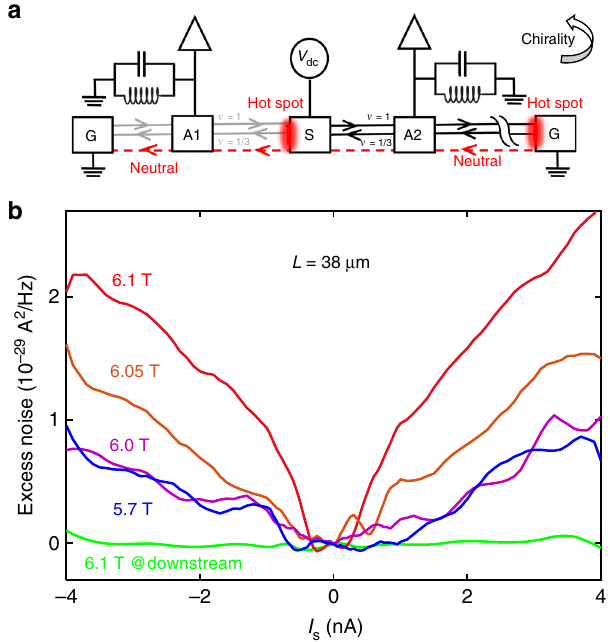
Fig. 4 Noise measurement setup and experimental results. a Schematic diagram of noise measurement circuit. Current is injected from source S and the upstream (downstream) noise is measured by a spectrum analyzer through ampli fi er contact A1 (A2). The contact is connected to an LC circuit at a center frequency f 0 = 1.3 MHz, with the signal ampli fi ed by a homemade (cooled) voltage pre-ampli fi er followed by a commercial, room temperature, voltage ampli fi er (NF-220F5). Note the gain of cold ampli fi er is taken as 7.5, but the precise gain value was not precisely calibrated. b Upstream excess noise in contact A1 as a function of I s at different magnetic fi elds. Green line represents the I s -independent (negligible) downstream excess noise at B = 6.1